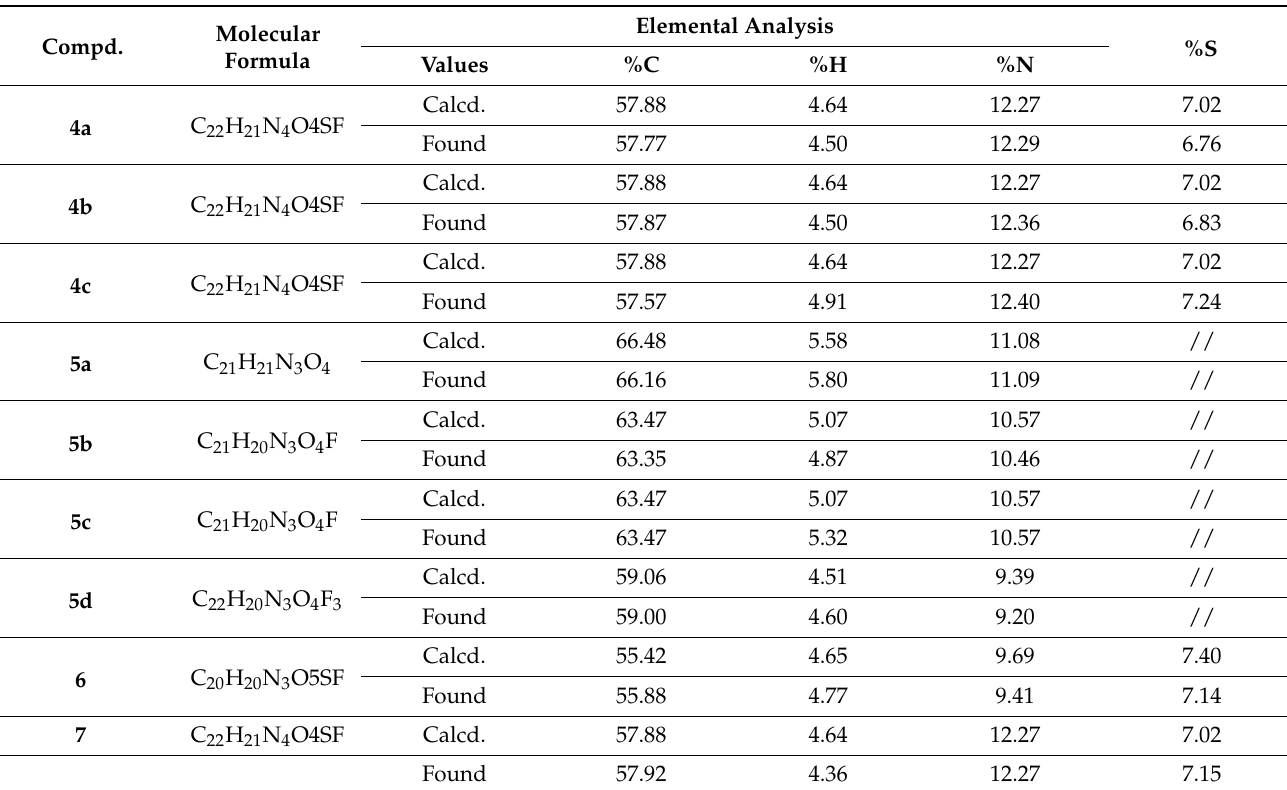
Table 7. Elemental analysis of compounds 4 - 7